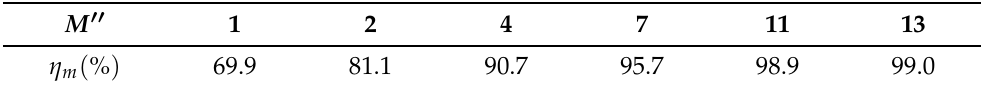
Table 1. Cumulative percentage variance of energy for various numbers of direction-related modes (left ear).